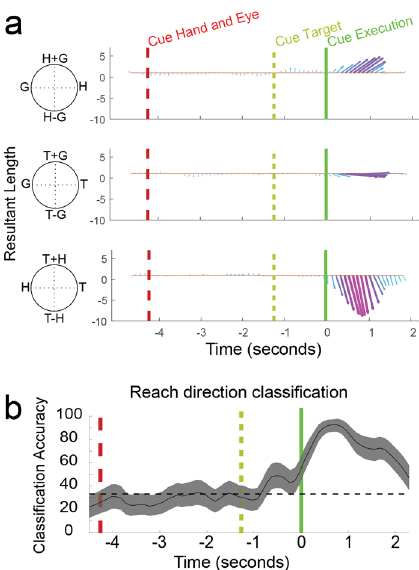
Fig. 4 Population dynamics of movement variable encoding. a Temporal evolution of reference frame encoding across the population of S1 units. Only the fi rst component (shown) was signi fi cant ( p < 0.05; parallel analysis). Arrow length, width, and color shows tuning strength. Schematic illustration of population gradient analysis is shown in Supplementary Figure 2. b Of fl ine analysis depicting cross-validated classi fi cation of reach direction initiated from the middle two hand positions to targets located above, to the right, and to the left of the starting hand position (see Supplementary Fig. 3 and Supplementary Fig. 4 for classi fi cation details). Sliding window classi fi cation performed on a 500-ms window stepped at 100 ms and is shown with mean and 95% bootstrapped con fi dence interval. Dashed horizontal black line shows chance accuracy